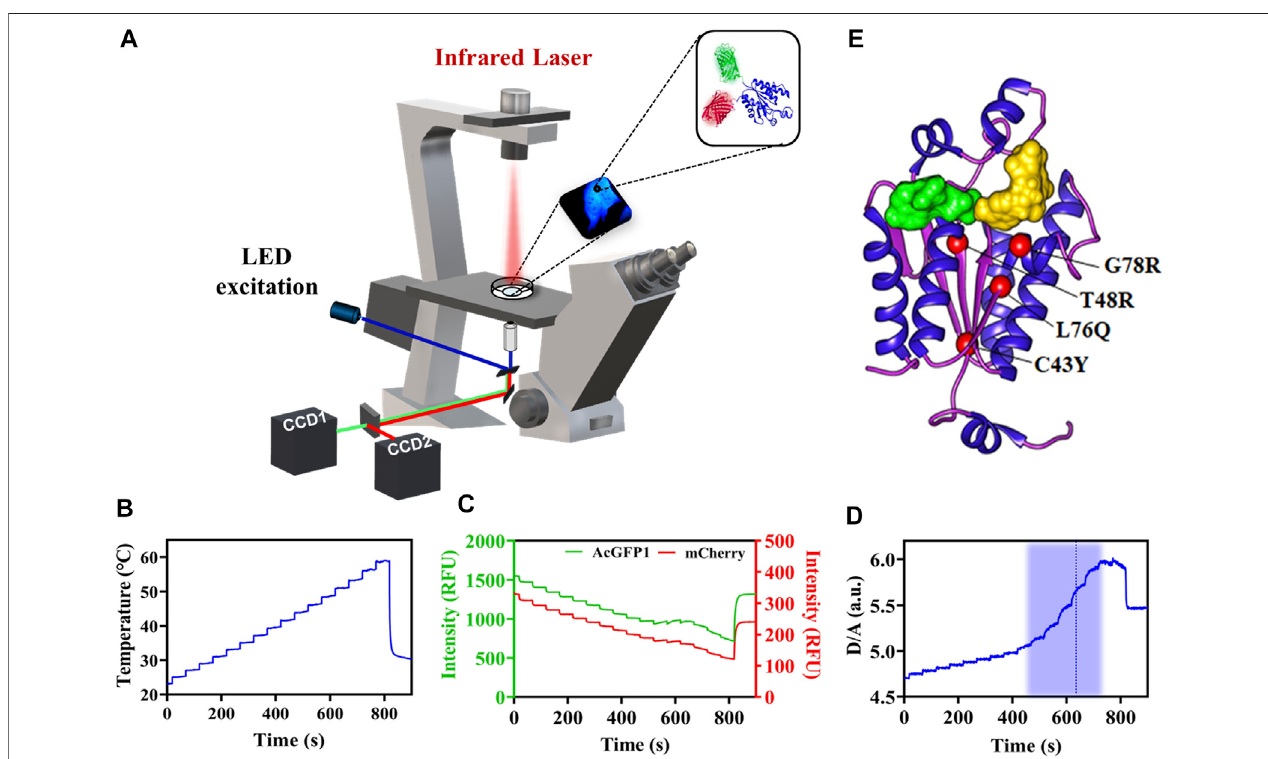
FIGURE1| In-cellthermal unfolding ofAPSK37wtusingFastRelaxationImaging. (A) Schematicrepresentation oftheFastRelaxationImagingsetup. (B) Induced temperature pro fi le calculated by the calibration procedure published in Büning et al., 2017. (C) Change in fl uorescence according to the temperature pro fi le in B of the APSK37 AcGFP1 FRET donor (D) and the mCherry FRET acceptor (A) . (D) D/A ratio calculated from the intensity data in (C) . The thermal unfolding region is shaded in blue and the calculated T M isdisplayed by adash blue line. (E) Crystal structure of the APSK domain of PAPSS2 (PDB:2AX4). Studied mutations are shown as red spheres. ADP/ATP (green) and APS/PAPS (yellow) binding sites are indicated by the substrates surface